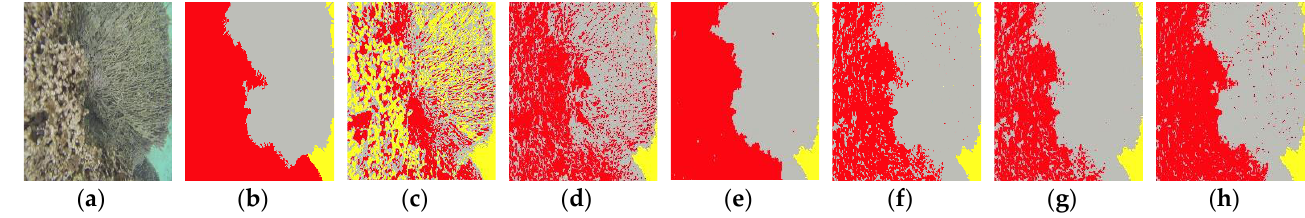
Figure 25. Validation tests of the proposed segmentation algorithms using low illuminated and high contrast coral image (1) from Figure 22 as example of two categories: ( a ) original image; ( b ) ground truth image; ( c ) KM result; ( d ) KMAc result; ( e ) FFCr result; ( f ) FRCr result; ( g ) OSCr result; ( h ) KMCr result. Gray: corals, and yellow: sediments.